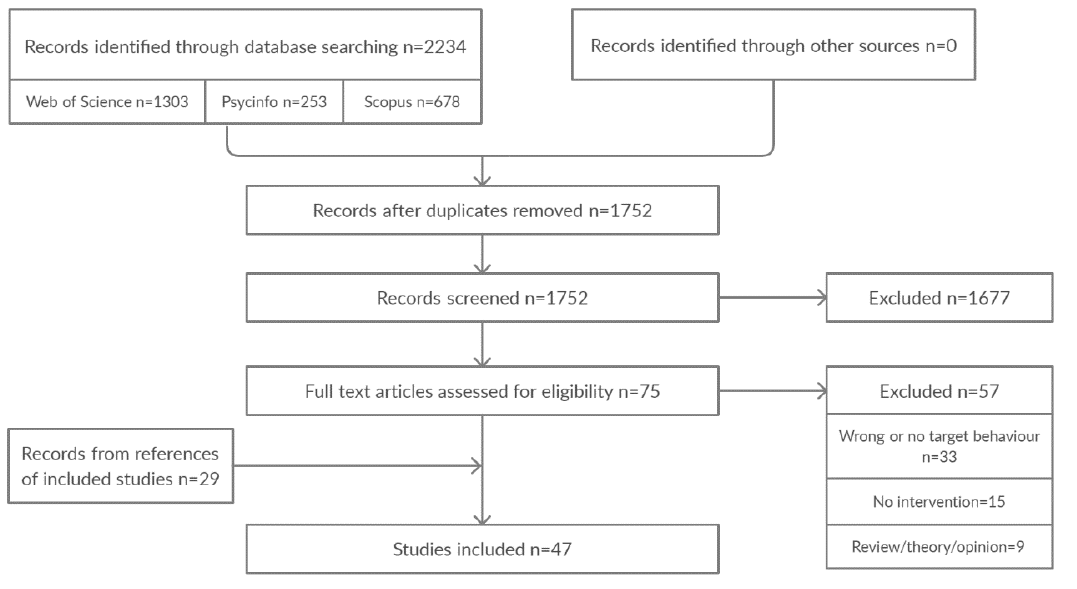
Figure 3. Screening process for structured review.